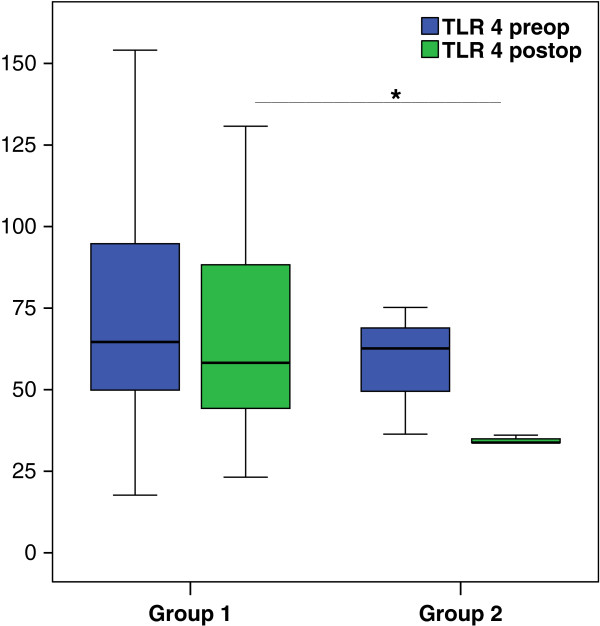
Toll-like receptor (TLR)4 expression on alveolar macrophages (AMs). The TLR4 expression did not differ before or after surgery in group 1 (n = 29) (P = 0.15). In group 2 (n = 3), TLR4 expression tended to be reduced (P not applicable (n/a)). Comparing the groups the baseline of TLR4 did not differ (P = 0.45). However, after surgery the TLR4 expression was significantly diminished in group 2 (P = 0.041). Box plots represent median and IQR; blue, values before surgery; green, values after surgery. The Wilcoxon test was used for dependent groups and the Mann–Whitney U-test for independent groups; *P <0.05.